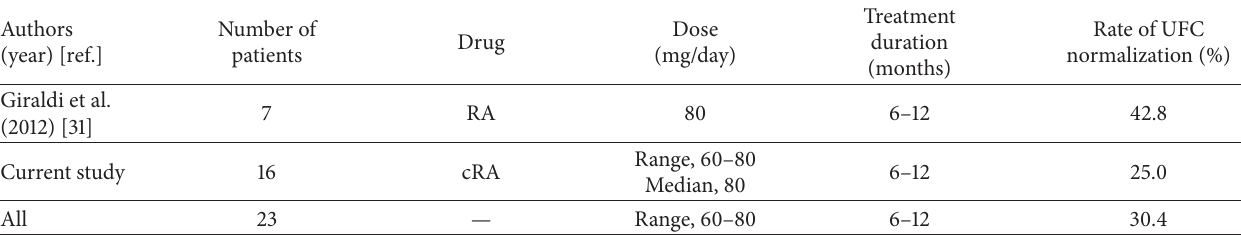
Table 4: Efficacy of retinoic acid (RA) and 13- cis- retinoic acid (cRA) in normalizing UFC levels in patients with Cushing’s disease ( data from 2 studies